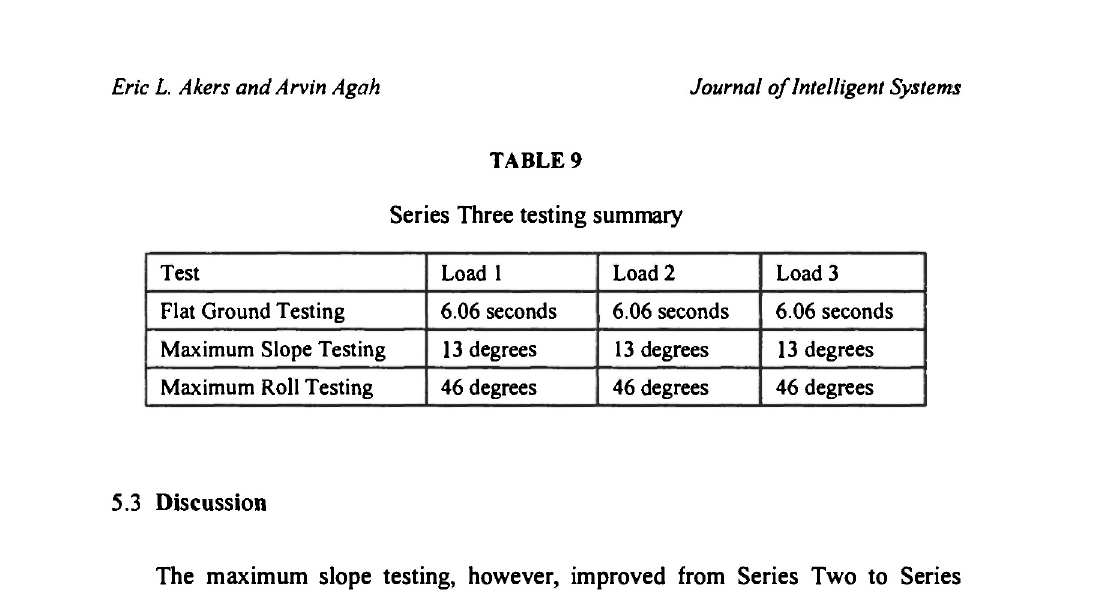
Series Three testing